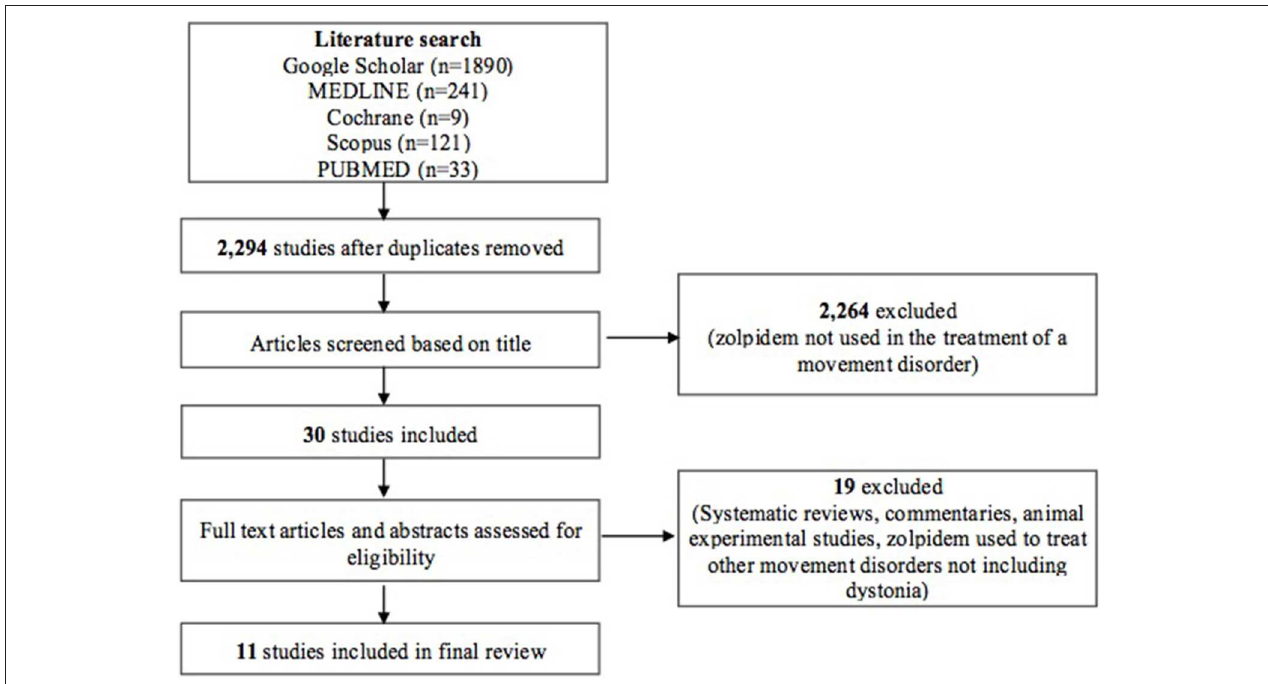
FIGURE 1 | PRISMA flow diagram illustrating selection of